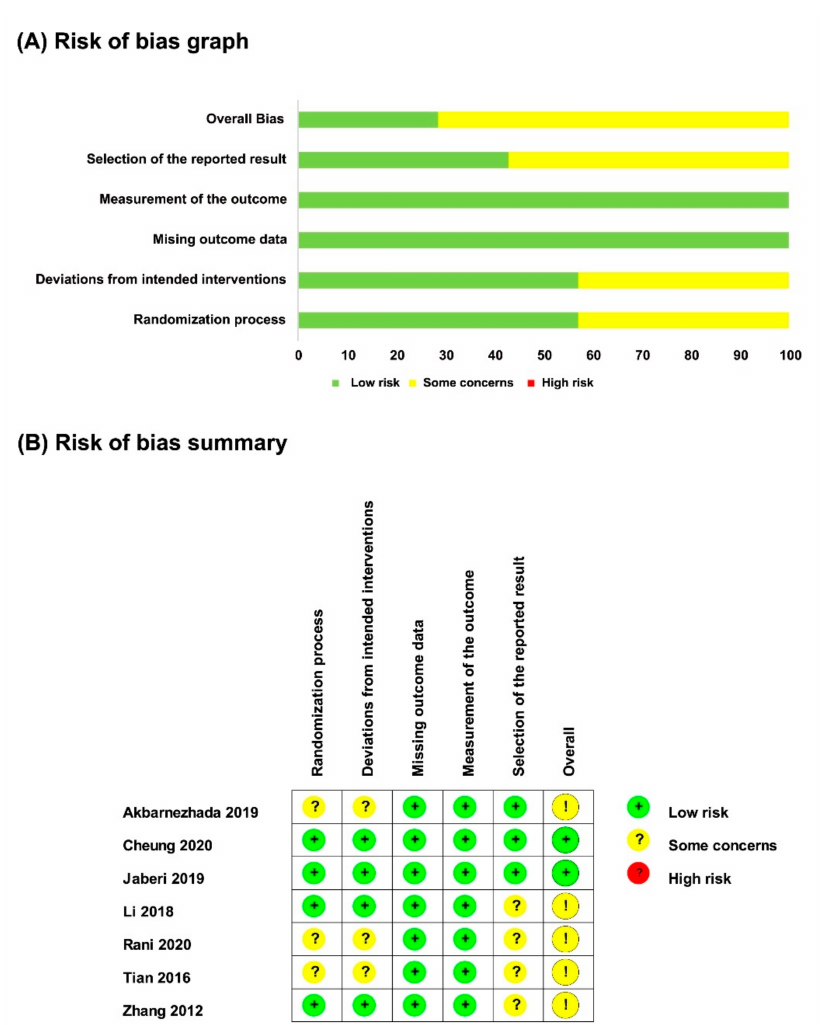
Figure 2. Risk of bias. ( A ) Risks of bias of the included studies. The authors reviewed each item’s risk of bias for each included study. ( B ) Risks of bias of individual studies. +: low risk of bias; − : high risk of bias; ?: unclear risk of